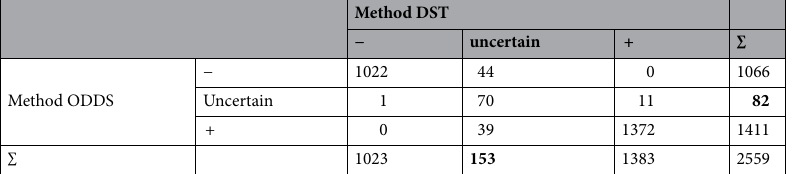
Table 4. DST Decision theory compared to ODDS. The same dataset (2559 samples) was subjected to DST and ODDS, both including the same uncertainty regions as described. DST is seen to flag 153 patients as uncertain, i.e. of questionable hormone receptor status. As compared to ODDS almost double as many patients are detected to be re-checked before therapies are assigned. Difference in methods is reflected in Cohen’s κ =